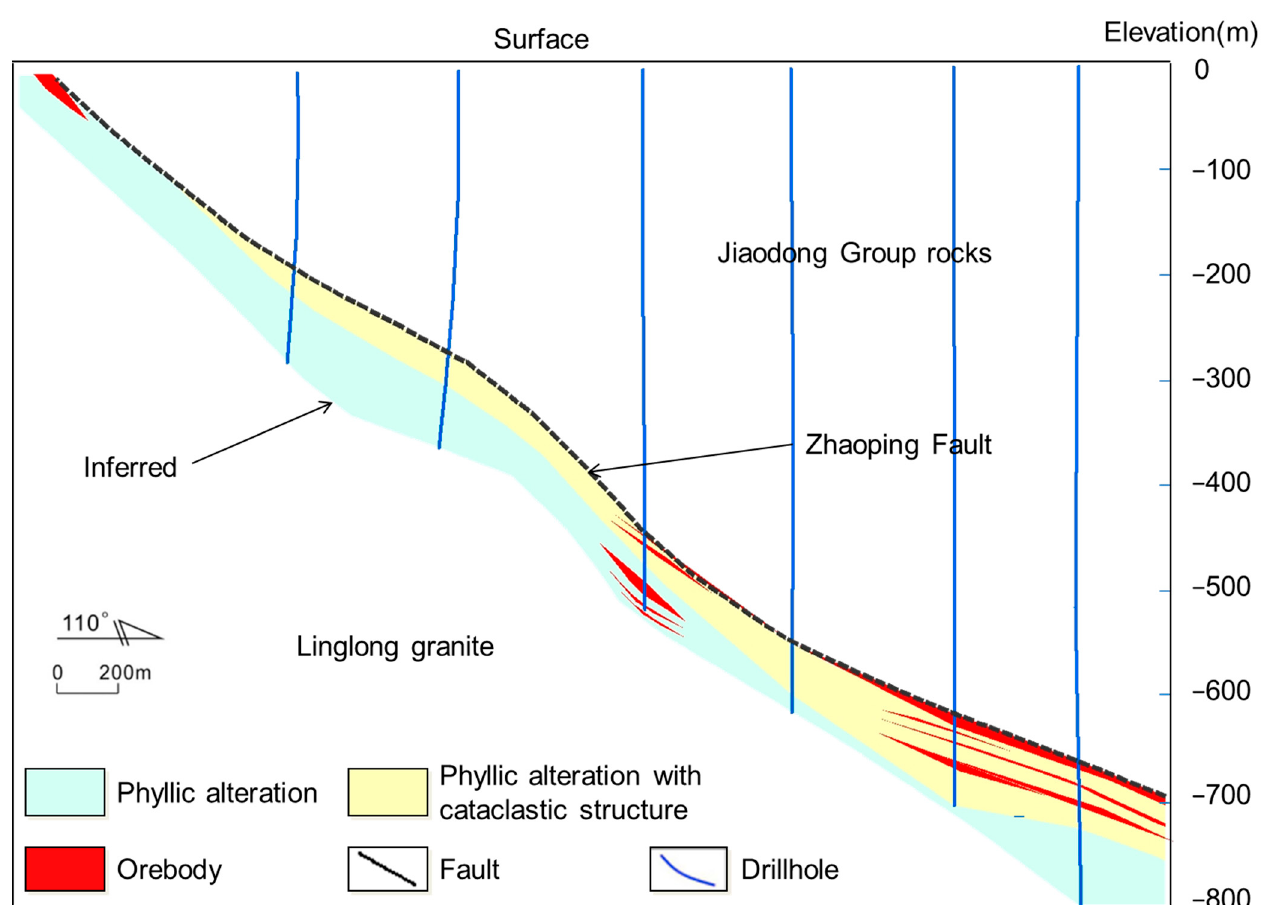
Figure 3. Geological section of the Dayingezhuang gold deposit. The cross-sections illustrate that orebodies mainly occur near the fault interface in the